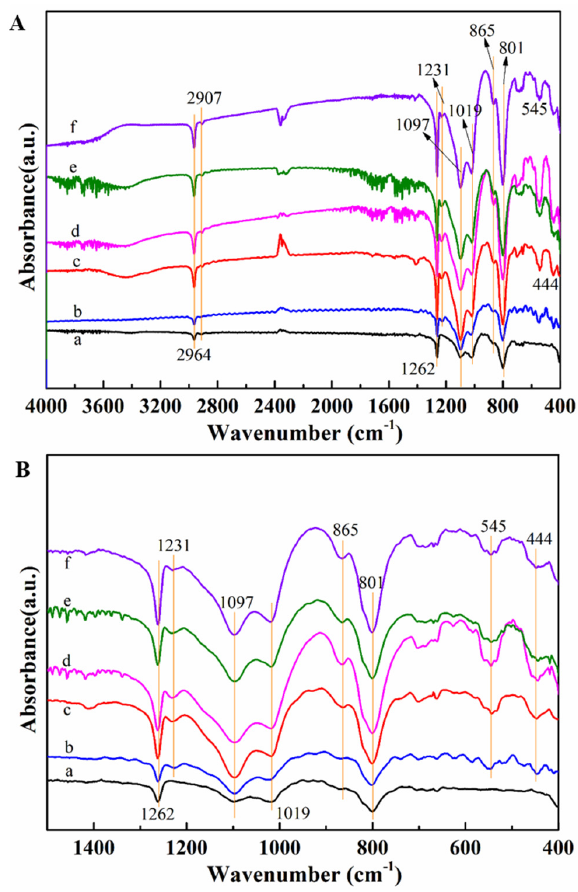
Figure 8. FTIR spectrums of the silicalite-1/PDMS/PVDF hybrid membranes with different silicalite- 1 zeolites content: (a) pure PDMS; (b) 5% loading; (c) 10% loading; (d) 15% loading; (e) 20% loading; and (e) 30% loading. ( B ) was the magnified segment of ( A ).